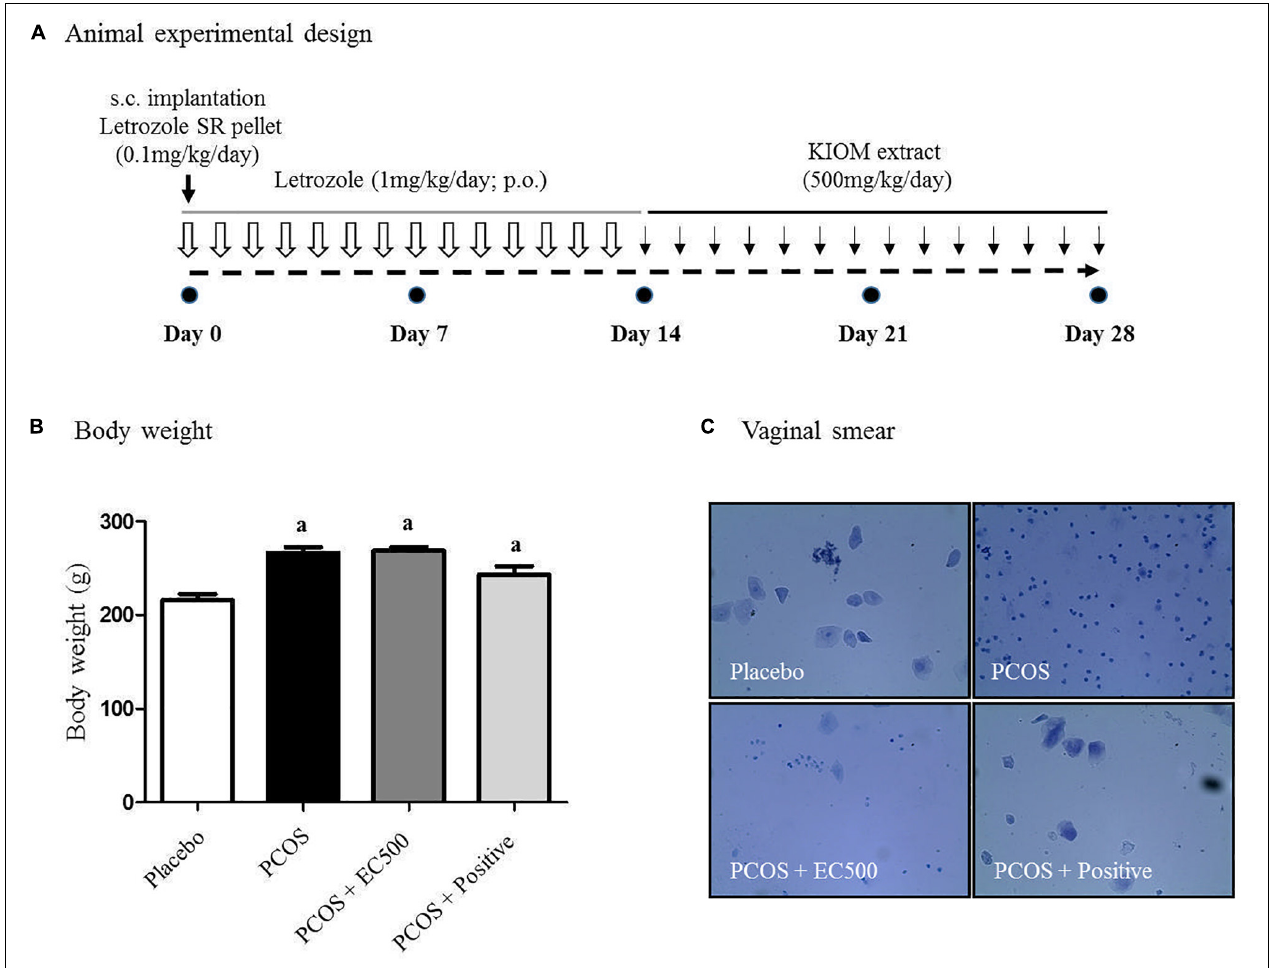
FIGURE 2 | Effect of E. cava treatment on physiological changes. (A) For PCOS experiments, 6-week-old female rats were administered letrozole pellets (0.1 mg/kg/day). After 2 weeks, E. cava extract was administered via P.O. treatment every day for 2 weeks. Treatment of rats in the PCOS+positive groups with pellets was removed 14 d after insertion. (B) Body weights were measured on the last day; a p < 0.05 vs. placebo group. (C) Vaginal smears were conducted on the last day, and hematoxylin staining was performed. Magnification, 100 × ; section of rat ovary. EC, E. cava extract; PCOS, polycystic ovary syndrome.